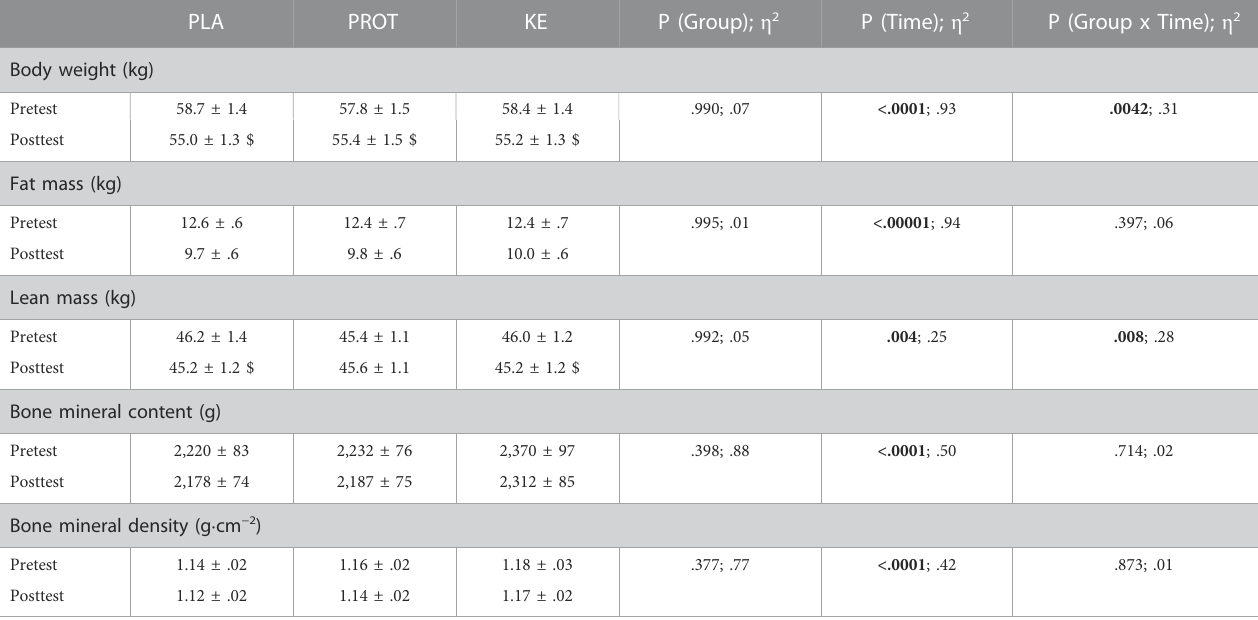
TABLE 2 Effect of increased protein intake andexogenous ketosis on body composition during a hypocaloricdiet. Data are mean ± SEM. Subjects were involved in a 4- week hypocaloric diet (30% energy restriction, .8 – 1.0 g protein · kg BW − 1 · day − 1 ) and received either placebo (PLA: n = 11), an increased amount of dietary protein (PROT: n = 10) or a ketone ester (KE: n = 11). Body composition was measured using DXA before (pretest) and at the end (posttest) of the caloric restriction period. Signi fi cantmaineffectsareshowninbold.Incaseofsigni fi cantinteraction, posthoc differences areshownas$:signi fi cantlydifferentfromthe correspondingvalueat pretest ( p < .05). Effect sizes are reported as eta squared ( η 2